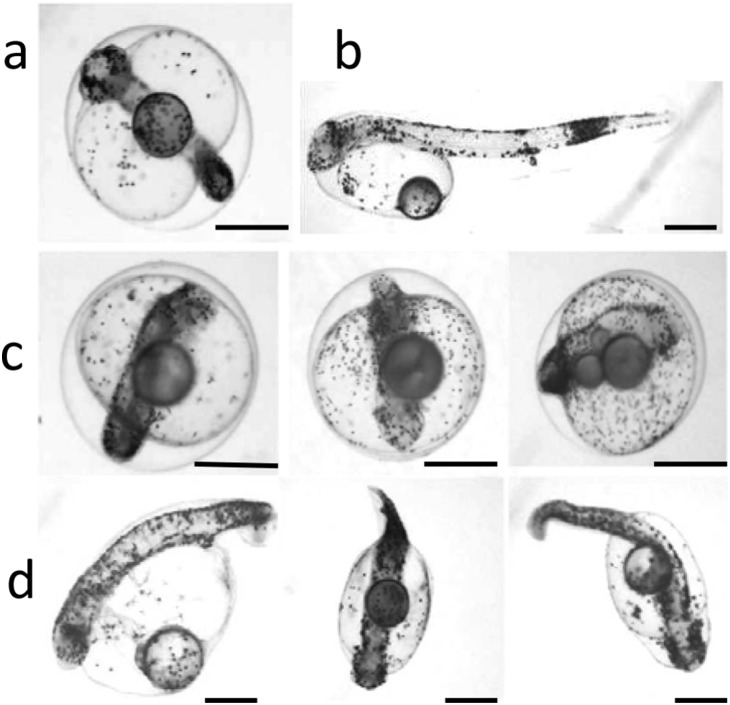
Morphology of control and UV-treated embryos and larvae.a) Control embryo at 74 h pf; b) control larva at hatching; c) UV treated embryos at 74 hpf showing microcephaly, short and large body; d) UV-treated larvae at hatching showing microphtalmy, short body and curved tail. Scale bars represent 500 µm.